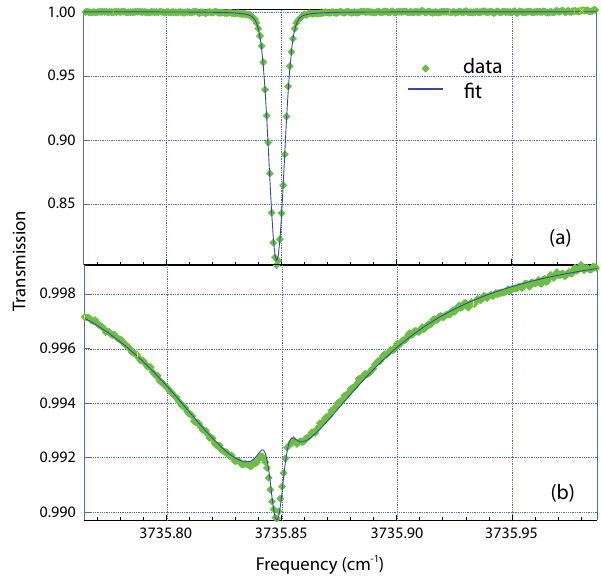
Fig. 2. Transmission spectra of (a) single reference beam and (b) normalized sample beam (sample spectrum divided by refer- ence spectrum). The reference gas mixing ratio was similar to but smaller than that of the sample gas, resulting in a negative residual spectrum (sharp peak) with 100 times smaller absorbance than that from the single beam spectrum. The broad spectral feature shown in (b) appears to be due to CO 2 absorption within the sample detector sealed